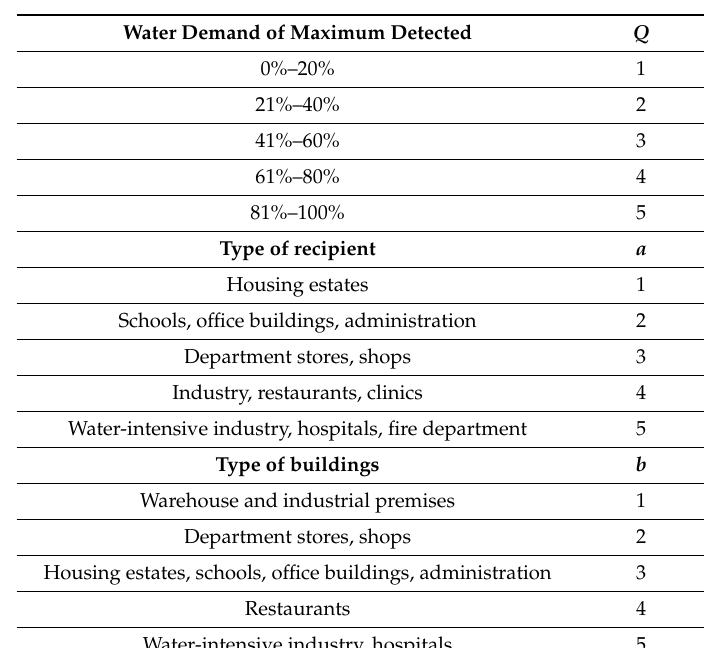
Table 1. Values of coe ffi cients describing the water demand ( Q ), required reliability of supply ( a ), and impact of supply failure ( b ) [17–19].